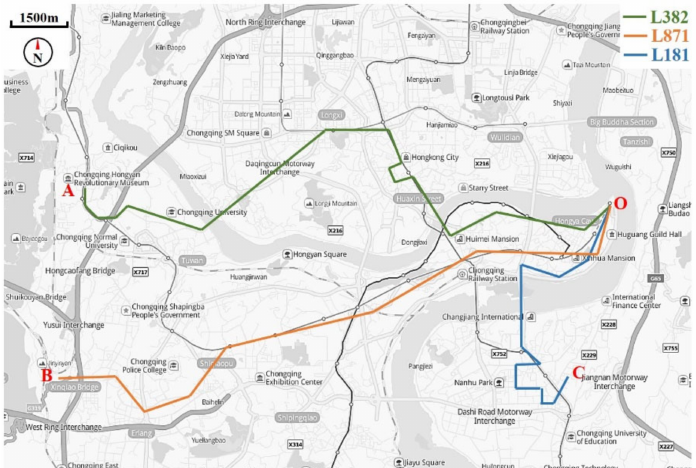
Figure 8. Map of the case in Chongqing, China (source: